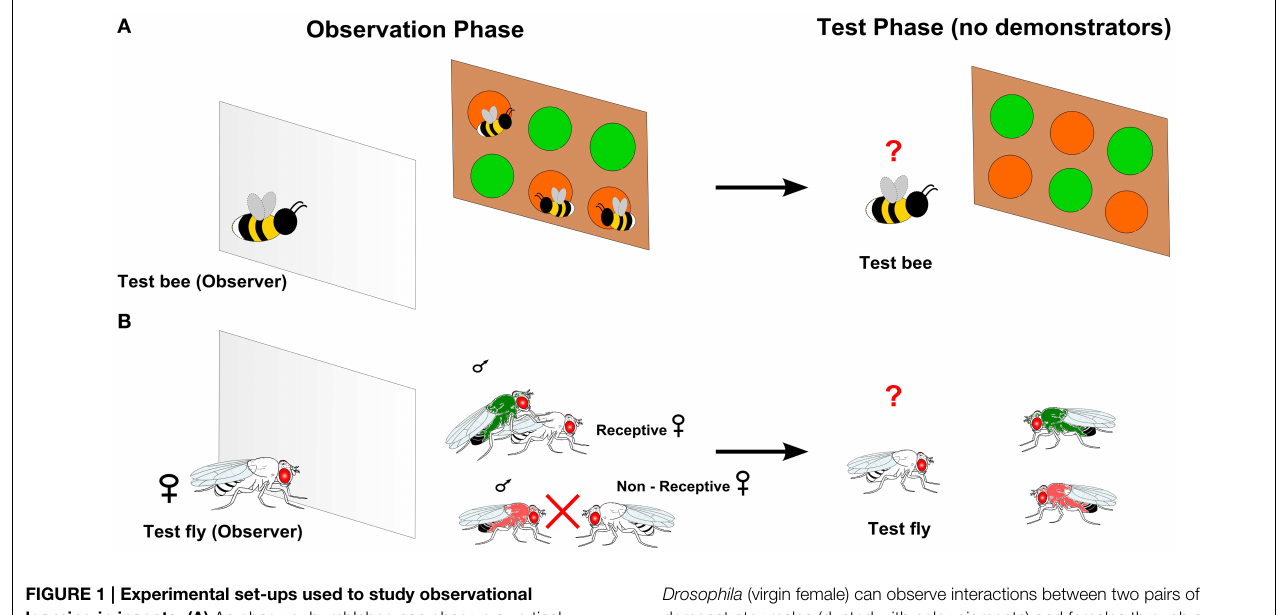
FIGURE 1 | Experimental set-ups used to study observational learning in insects. (A) An observer bumblebee can observe a vertical array of two unfamiliar flower types (e.g., green or orange) through a transparent screen. Demonstrators (e.g., living bees, dead bees or model bees) are associated to one flower type (e.g., green). Observational learning is successful if the observer bee preferentially visits flowers of the same type as the demonstrators did, when subsequently tested alone (Worden and Papaj, 2005; Avarguès-Weber and Chittka, 2014b). (B) An observer